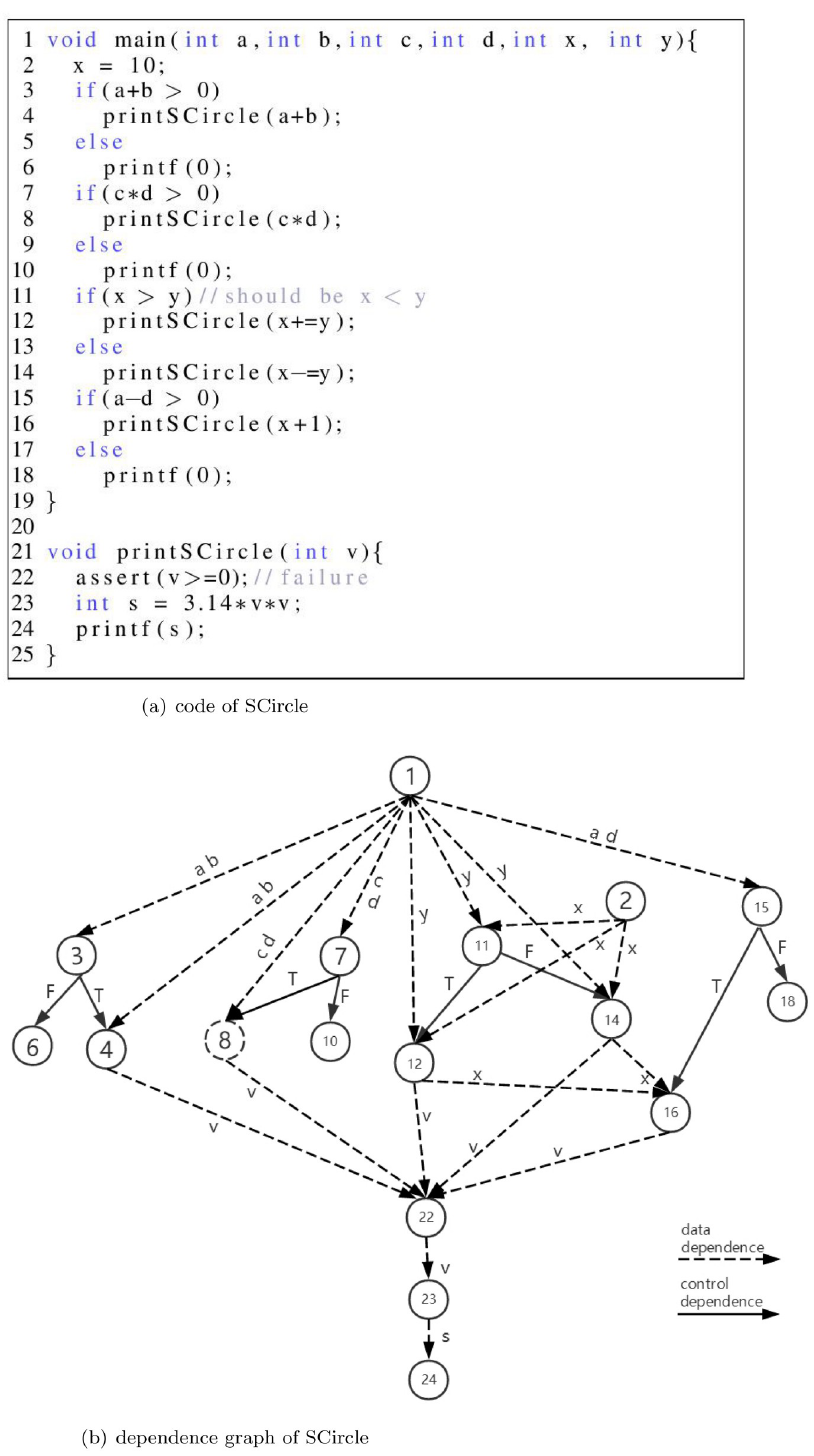
Fig 1. Illustrative program: